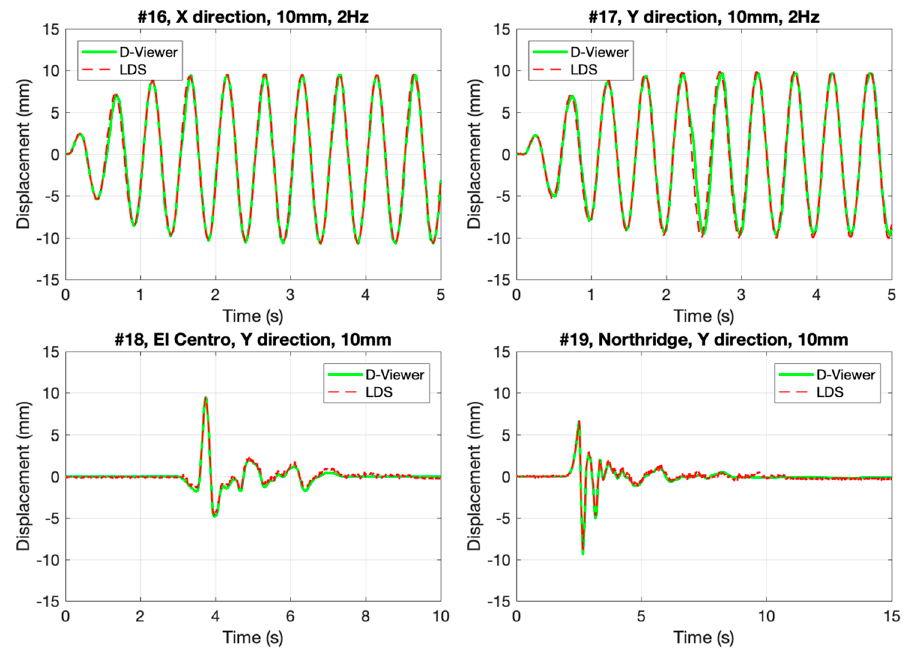
Figure A5. Experiment results of #16 to #19.